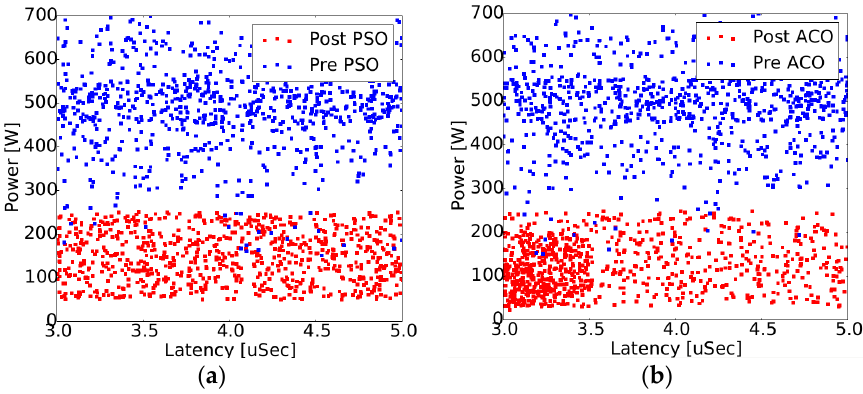
Figure 7. lu benchmark power consumption and latency solution space ( a ) pre, post PSO ( b ) pre, post ACO. Electronics 2016 , 5 , 21